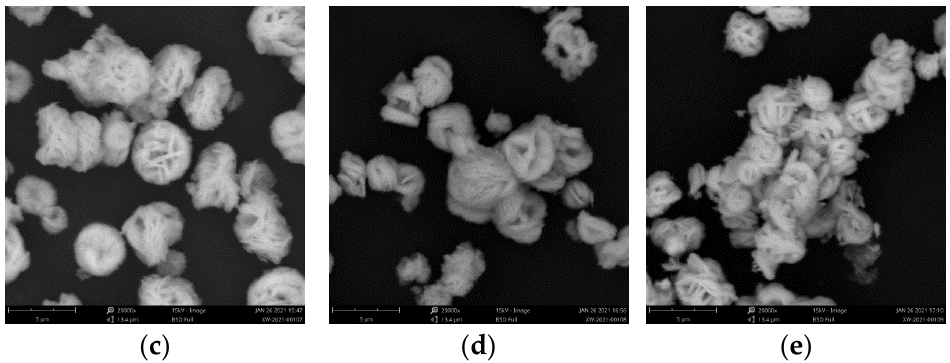
Figure 1. SEM images of as-prepared photocatalyst: ( a ) ZnIn 2 S 4 ; ( b ) Bi 2 WO 6 ; ( c ) 0.1-Zn/Bi; ( d ) 0.2-Zn/Bi; ( e ) 0.3-Zn/Bi.